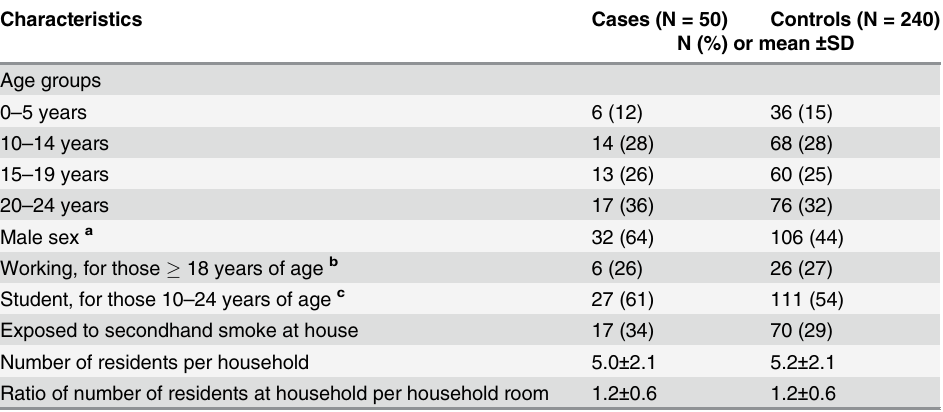
Table 2. Characteristics of case patients with laboratory-confirmed serogroup C meningococcal dis- ease and age-matched residents of affected neighborhoods included in case-control study, Salvador, Brazil, 2010.